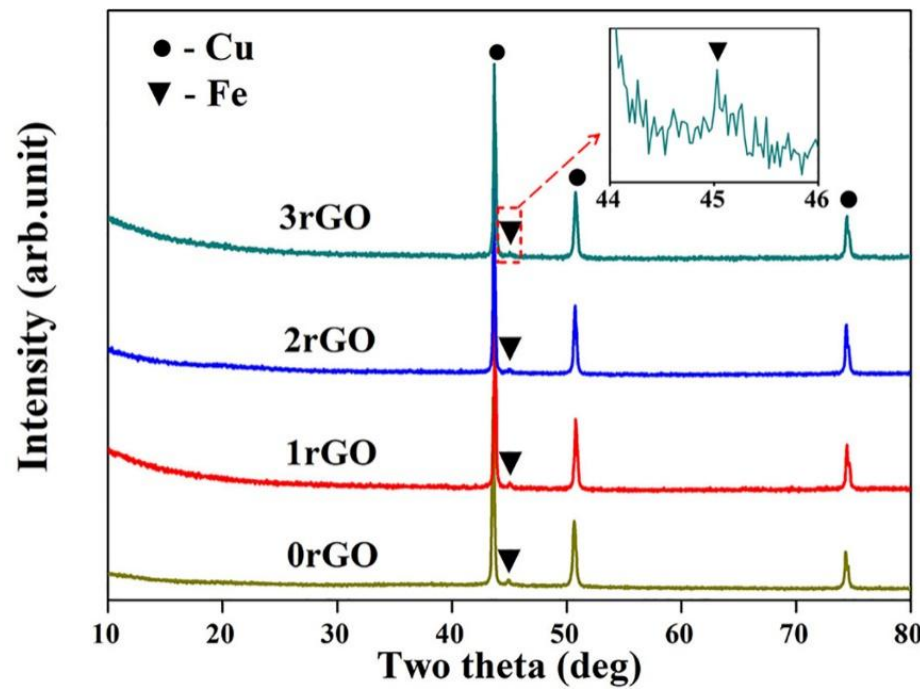
Figure 6. XRD patterns of the sintered bulk compacts. The inset shows the diffraction peak of Fe phase in the bulk compacts.